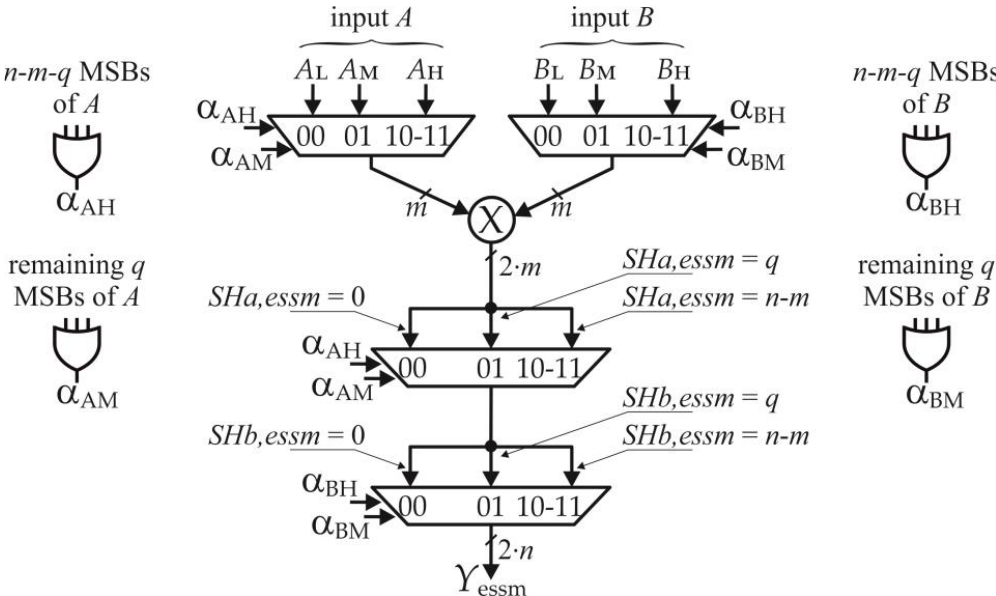
Figure 4. Block diagram of the proposed generalized ESSM multiplier.